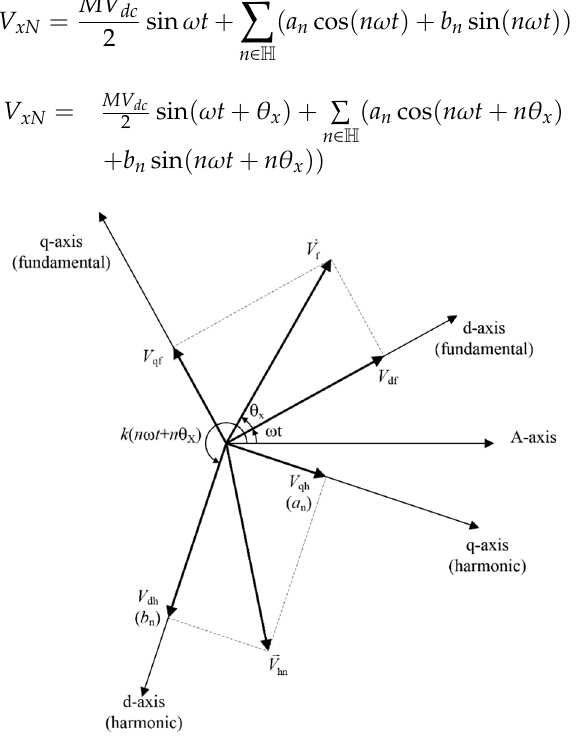
Figure 14. The relationship among the voltage vectors in synchronous d-q frame.